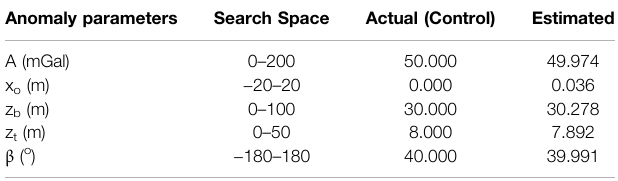
TABLE 1| Searchspace,actualand estimatedparametersuncorruptedsynthetic gravity anomaly.